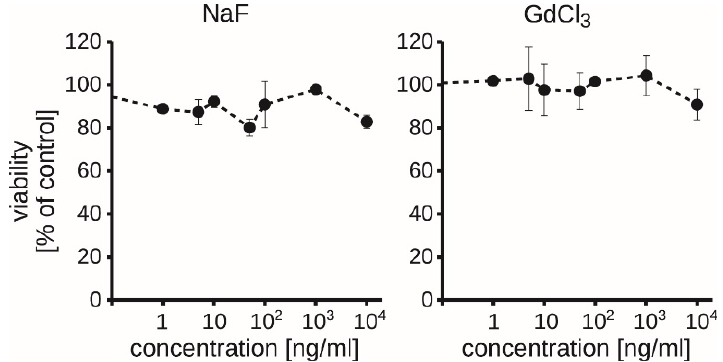
Figure 8. Viability of RAW264.7 cells ± SD after a 48-h treatment with soluble gadolinium and fluoride salts ( n = 3).